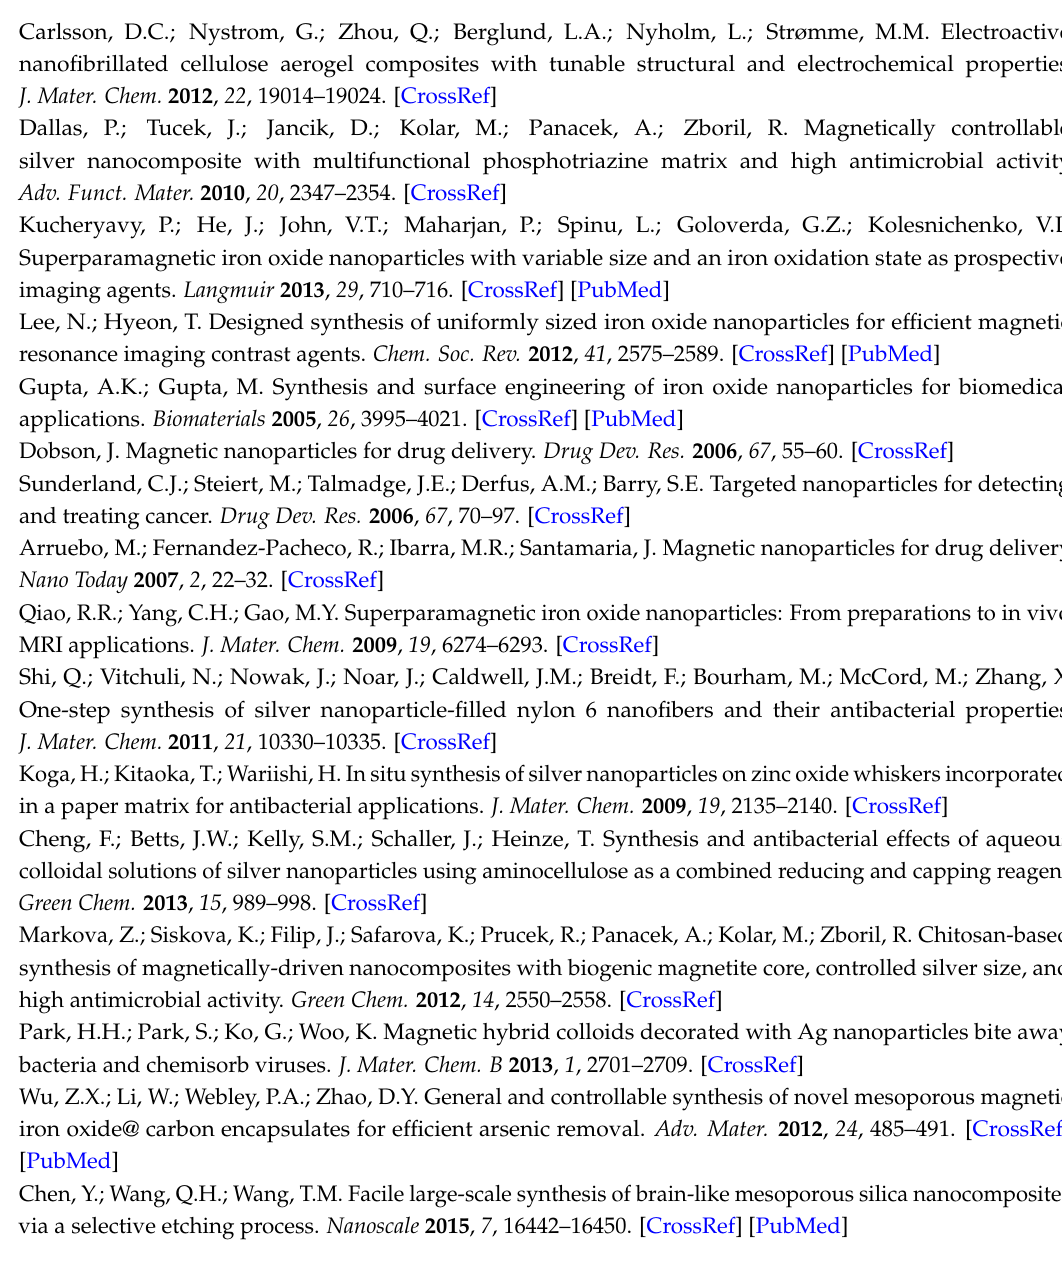
Figure S1: SEM of Ag@Fe 3 O 4 @Silk fiber